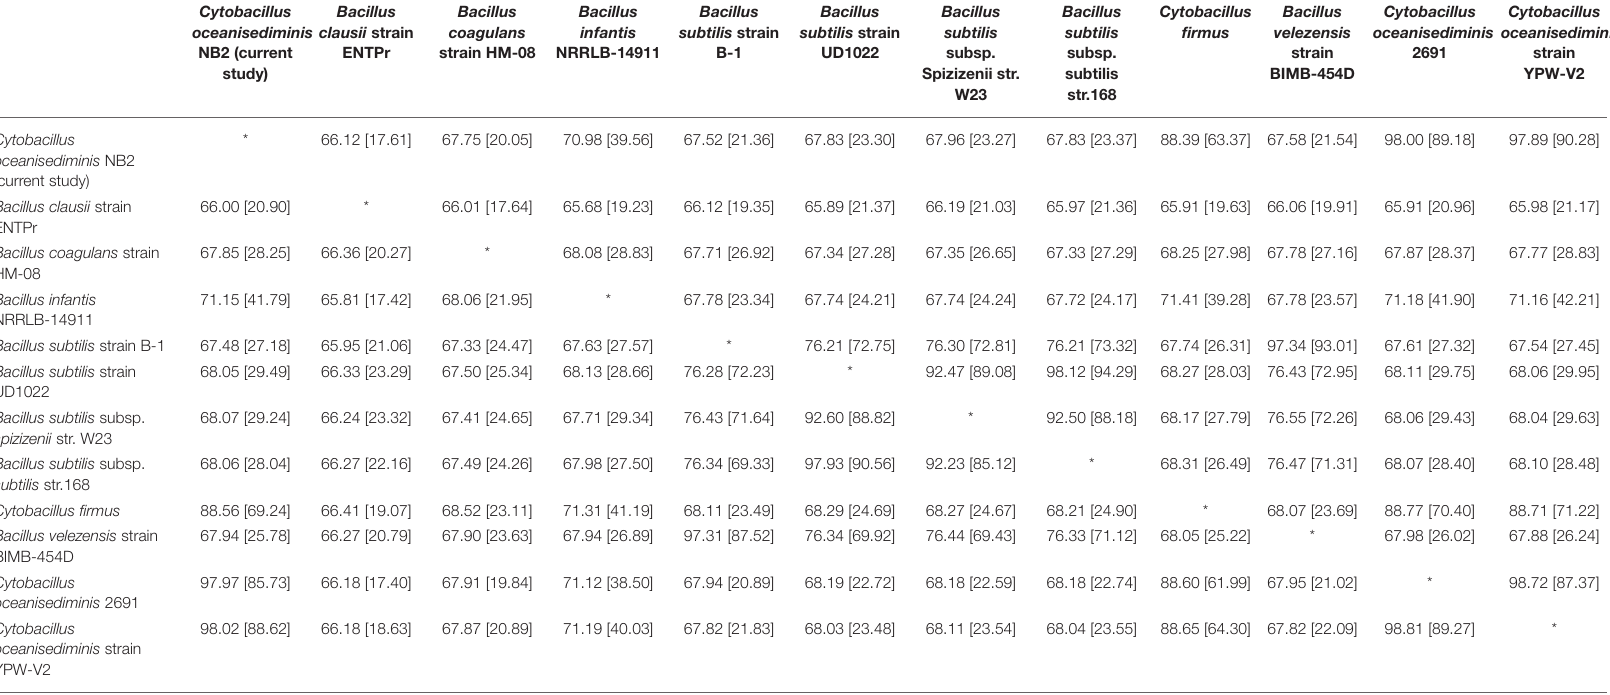
* Indicates the ANI between the same